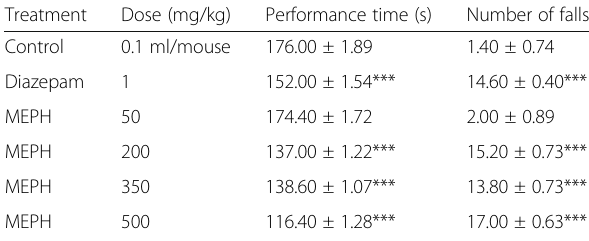
Fig. 3 The effect of MEPH on the rota rod test (performance time as seconds and number of falls) in mice